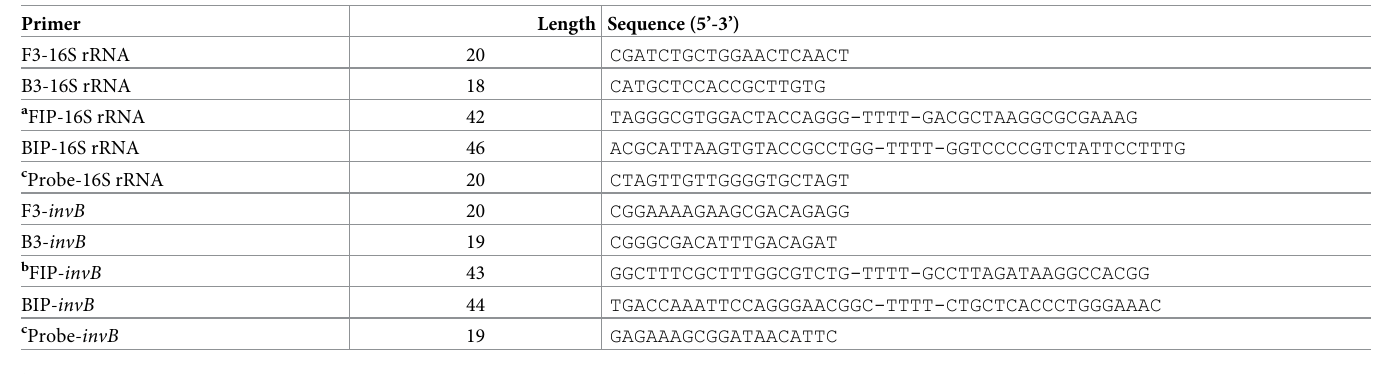
Table 1. Nucleotide sequences of d-LAMP-LFB primers and probes used in this